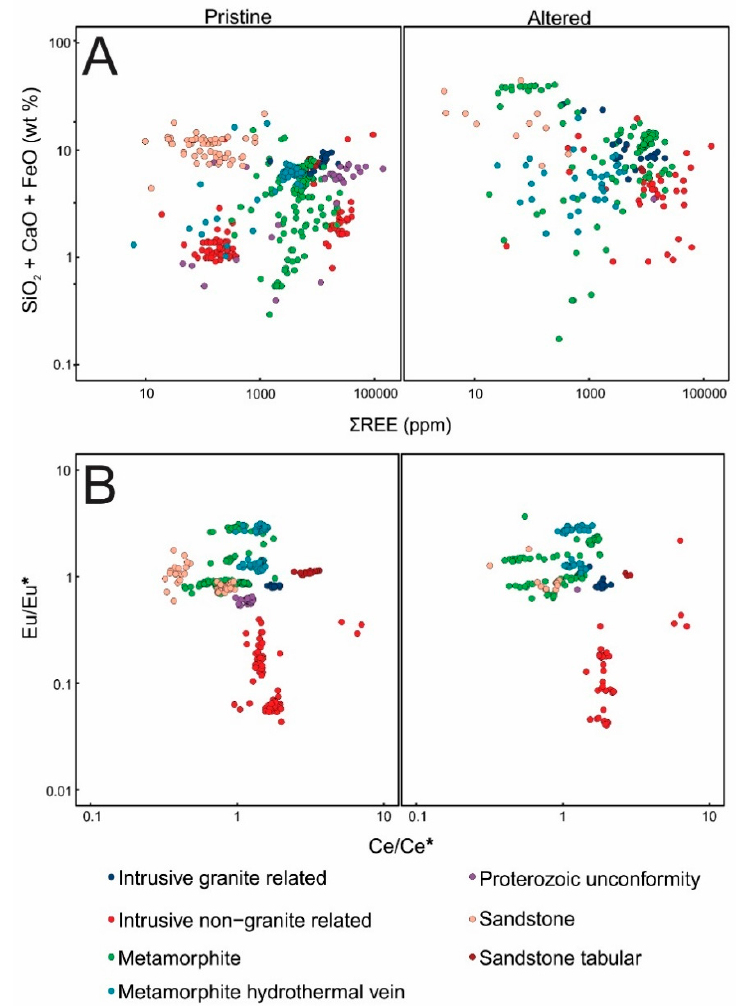
Figure 4. ( A ) Log–log plot of total cation (wt. %; SiO 2 + FeO + CaO) versus total REE (ppm) for pristine and altered uraninite samples. ( B ) Europium versus cerium anomaly. Eu / Eu* = Eu CN / (Sm CN + Gd CN ) 0.5 and Ce / Ce* = 3*Ce CN / (2*La CN + Nd CN ) for pristine and altered uraninite samples.